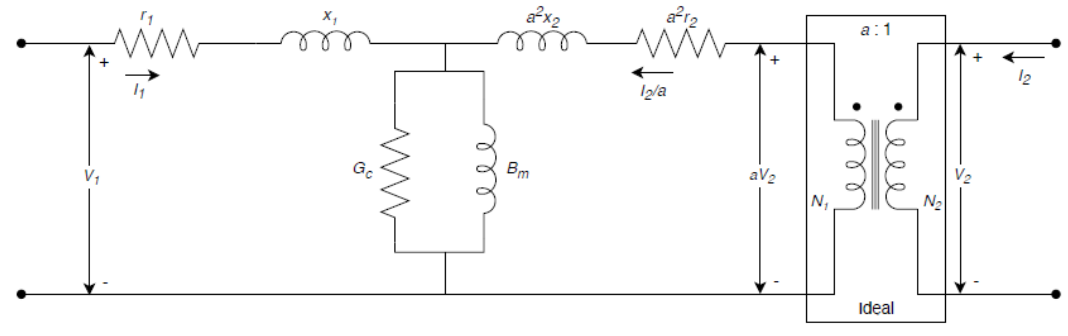
Figure 2. Equivalent circuit model of a power transformer.